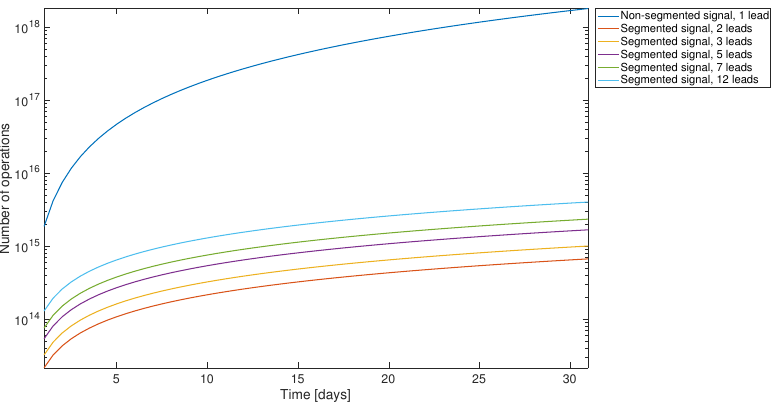
Figure 5. Mean detection errors and processing times for different segment lengths in the proposed algorithms.